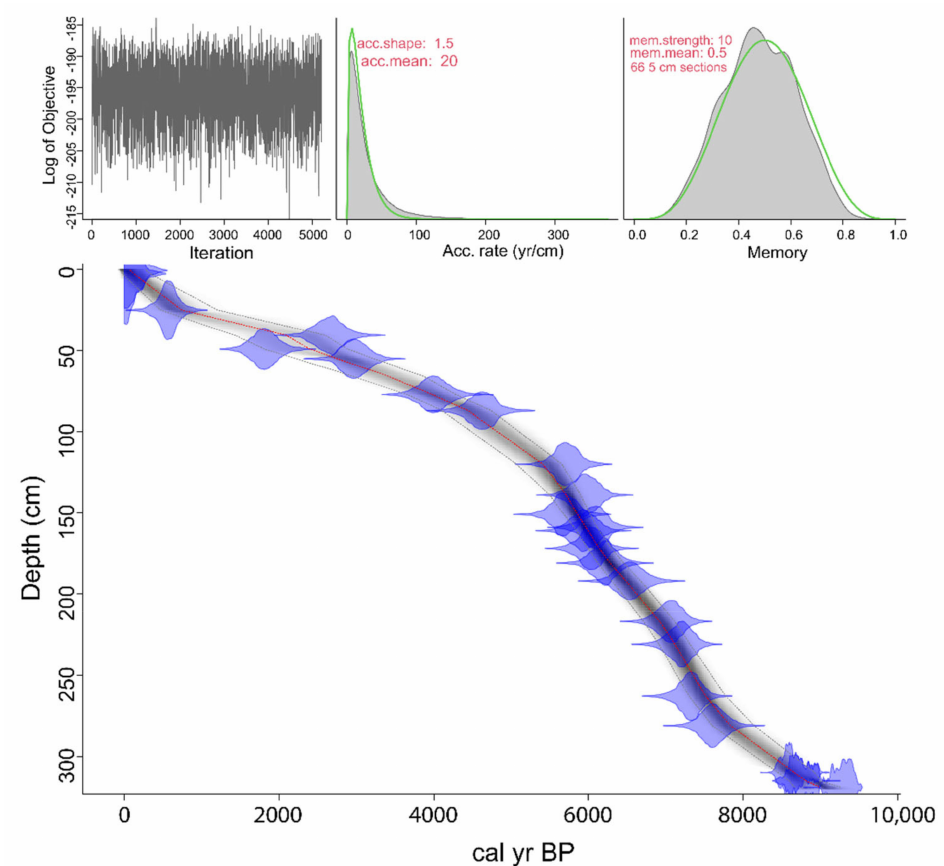
Figure 5. Bayesian age-depth model for ASTC1 sediment core in cal yr